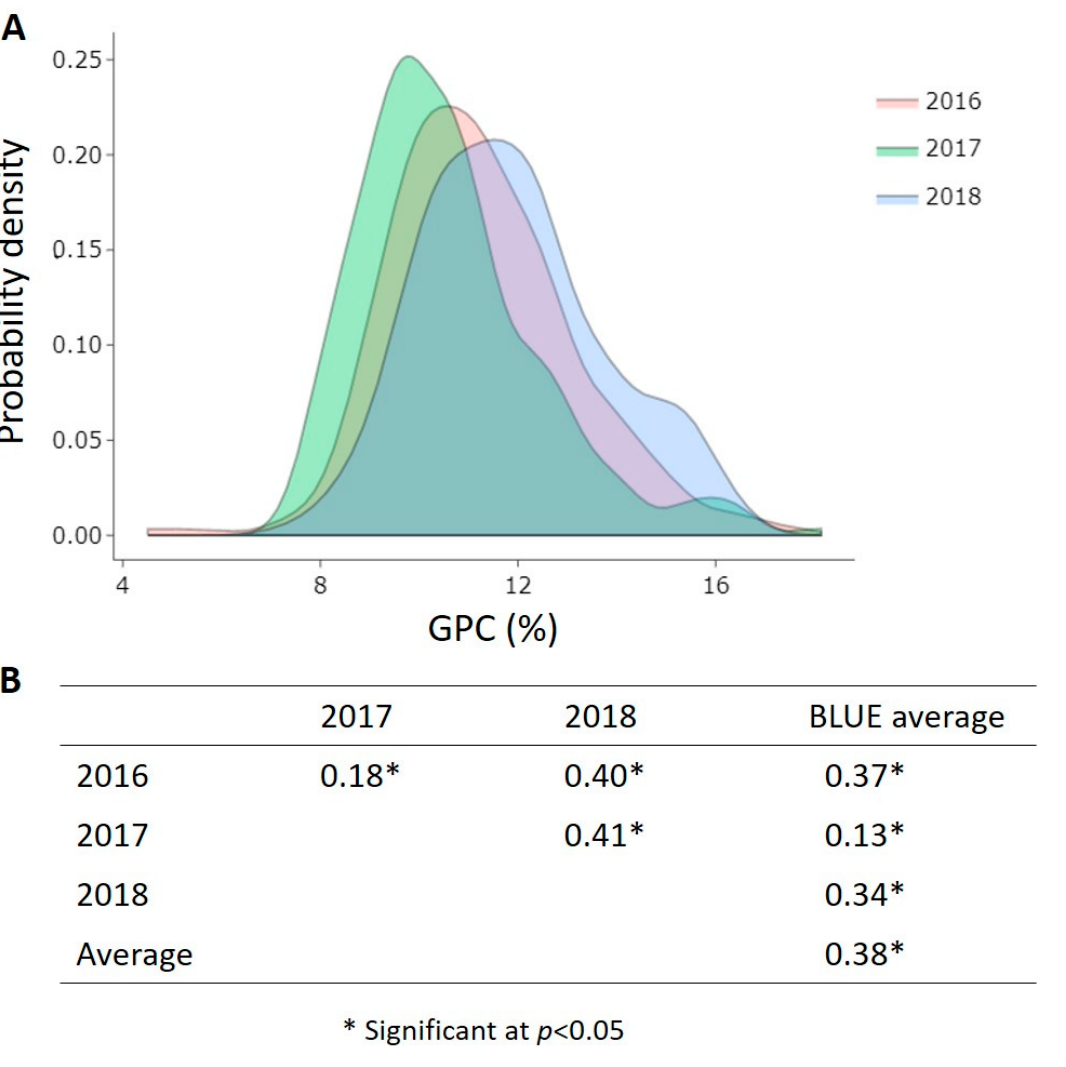
Figure 2. ( A ) Probability density of 255 bread wheat accessions from 27 countries for GPC (%) across three growing seasons (2016, 2017, 2018); ( B ) Pearson correlation coefficient values r of GPC among all measured environments and the BLUEs.